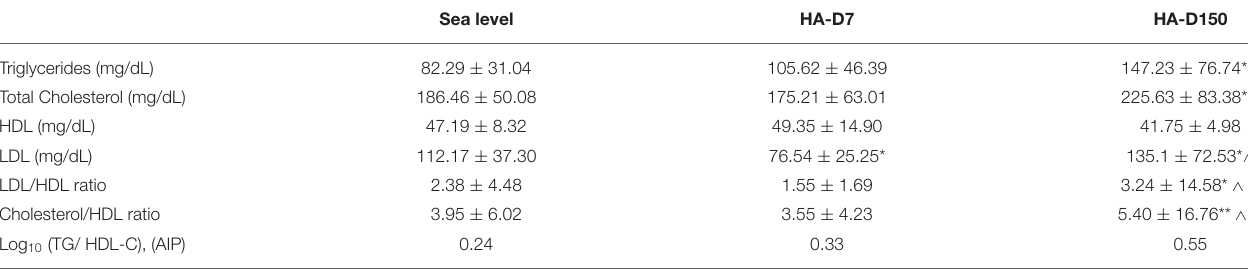
TABLE 2 | Assessment of lipid profile at sea level, 7 days, and 3 months ( n = 8).